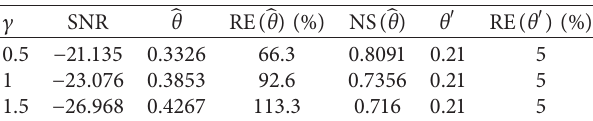
Table 2: Calibration performance for different noise